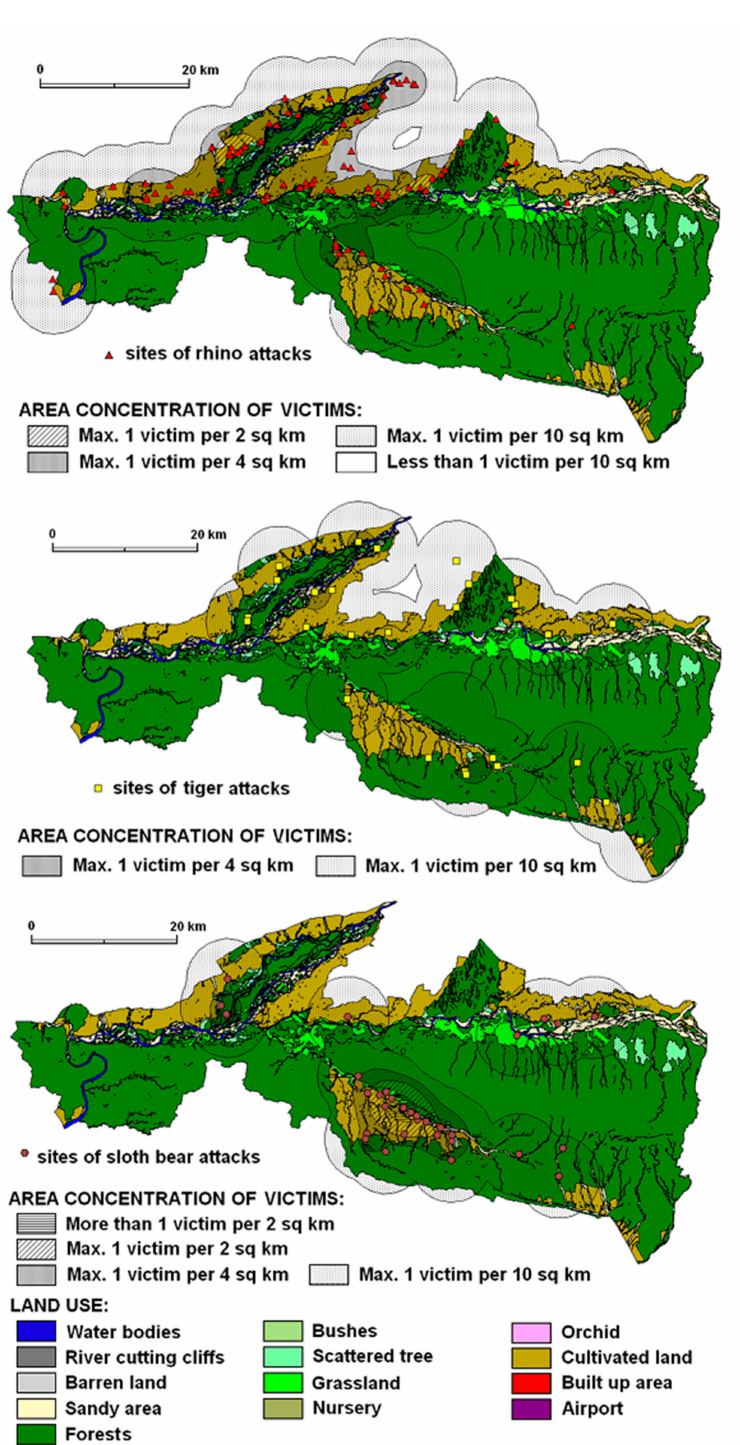
Figure 3. Density areas of recorded attacking animals (rhinoceros, tiger and sloth bear) within di ff erent land use